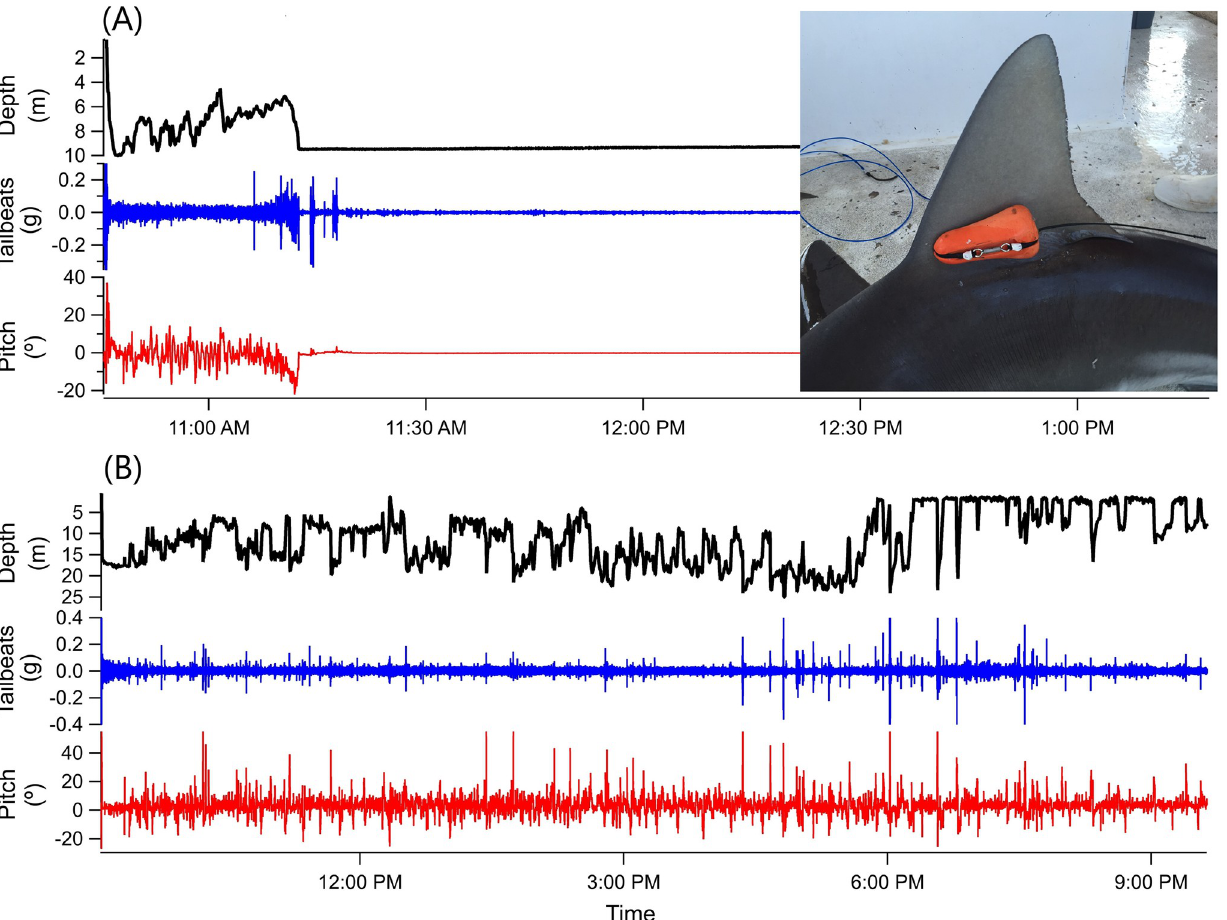
Fig 1. Acceleration traces depicting a post-release mortality (A) and post-release survival (B). Temperature, depth, pitch, and tailbeat movements for (A) a blacktip shark that died after release and (B) a sandbar shark that survived capture and release showing typical “yo-yo” diving behavior. The blacktip shark swam for 30 min before settling on the bottom in normal (dorsal side up) posture, and exhibiting erratic tailbeats for approximately five minutes until all movement ceased around 11:20 am. Inset shows a sandbar shark dorsal fin with ADL float package attached (Lear and Whitney 2016 [46]).